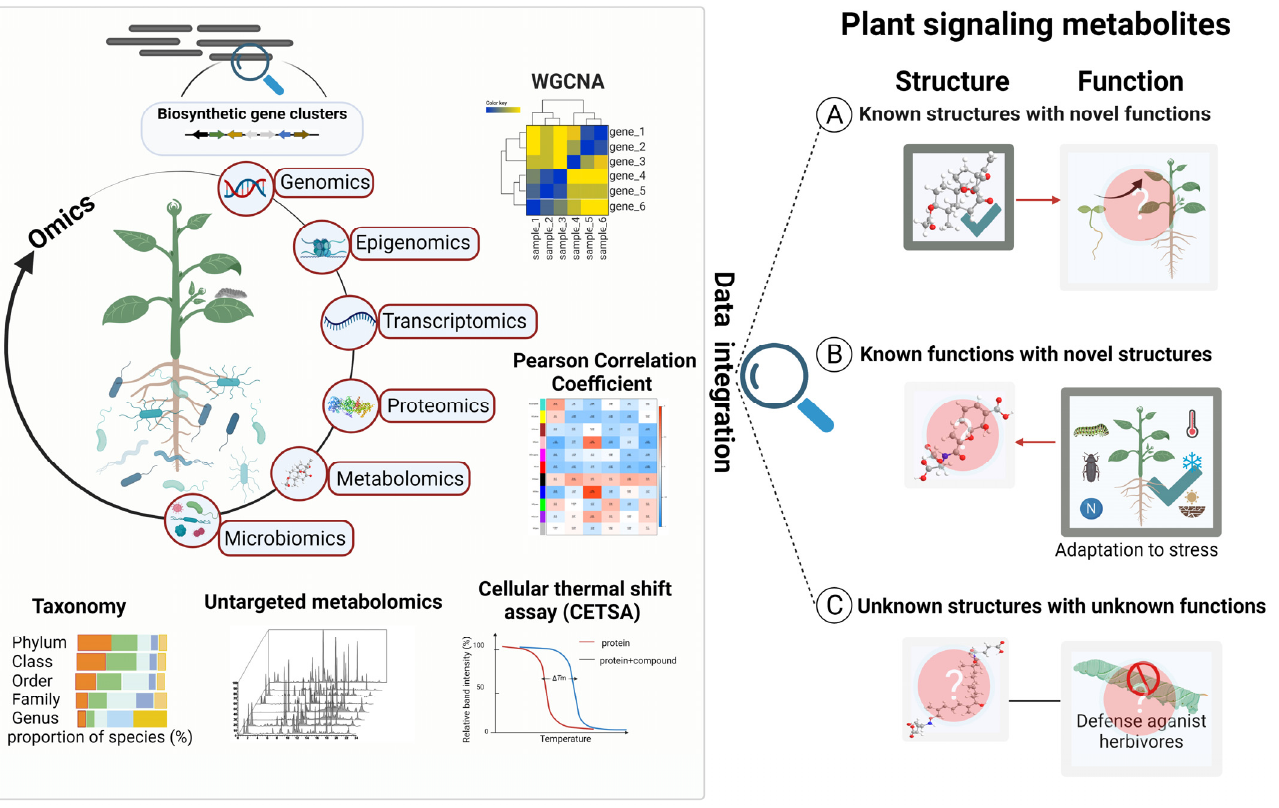
Figure 1. Overview of multi-omics for plant signaling metabolite discovery. Key tools at the different levels of omics for plant signaling discovery are highlighted on the left panel. The different categories ( A – C ) of plant signaling metabolites awaiting discovery are depicted on the right panel. WGCNA, weighted gene co-expression network